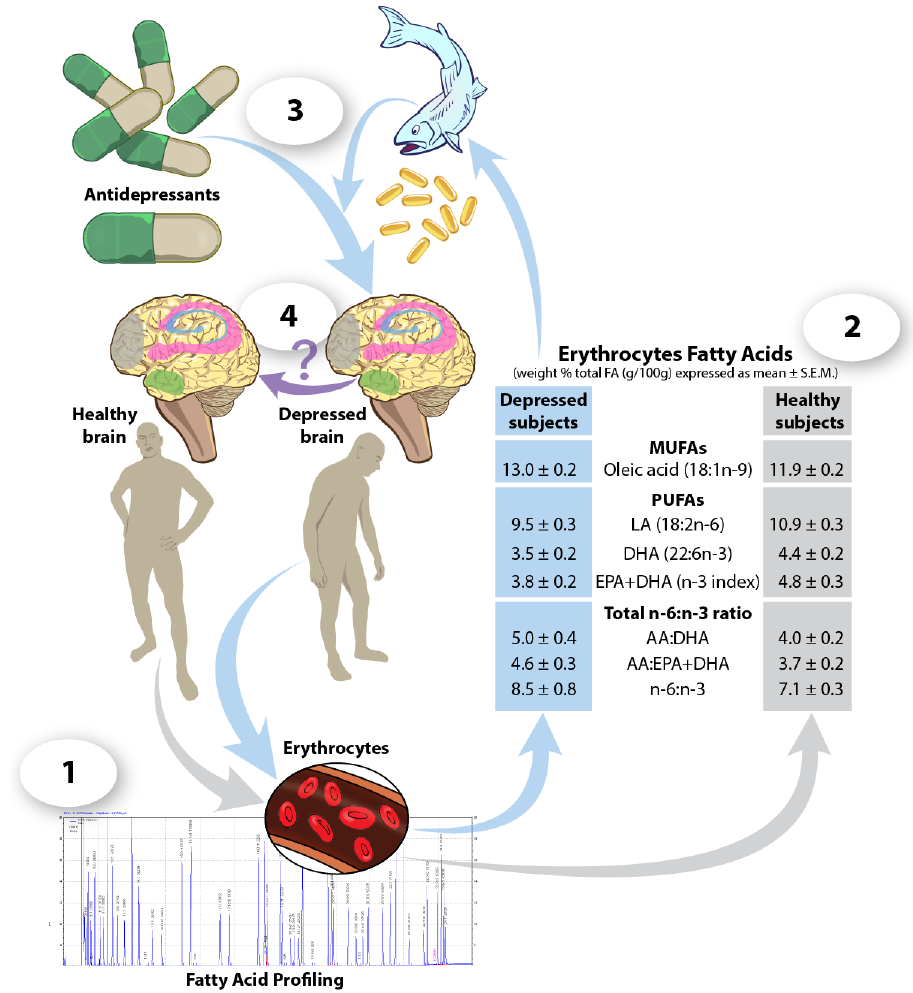
Figure 1. Dietary fats as a potential adjunct to antidepressant medication. ( 1 ) Profiling